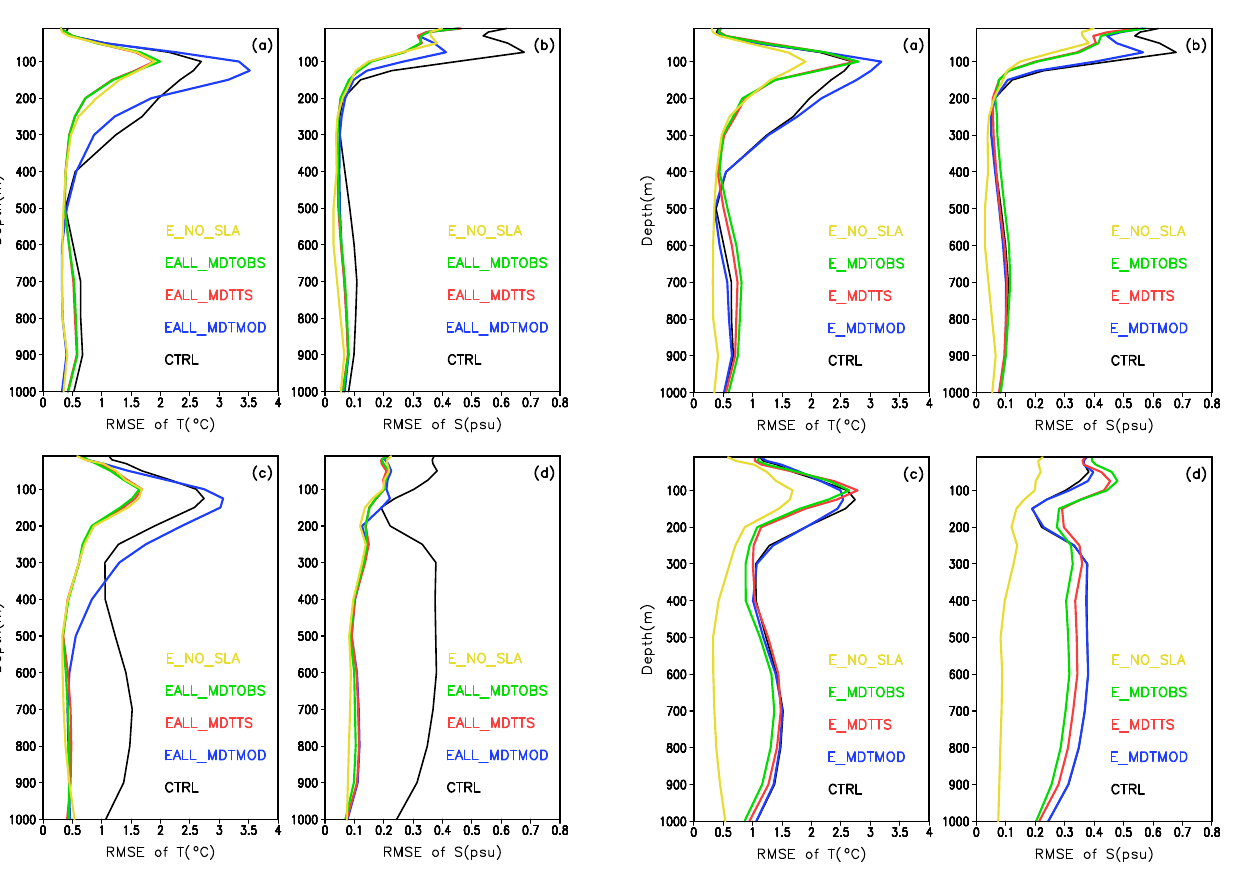
Figure 7. RMSEs of temperature (left; unit: ◦ C) and salinity (right; unit: psu) from different experiments in the northeastern Indian Ocean including the Bay of Bengal (a, b) and the northwestern Indian Ocean including the Arabian Sea (c, d) . Black: CTRL; blue: E_MDTMOD; red: E_MDTTS; green: E_MDTOBS; yellow: